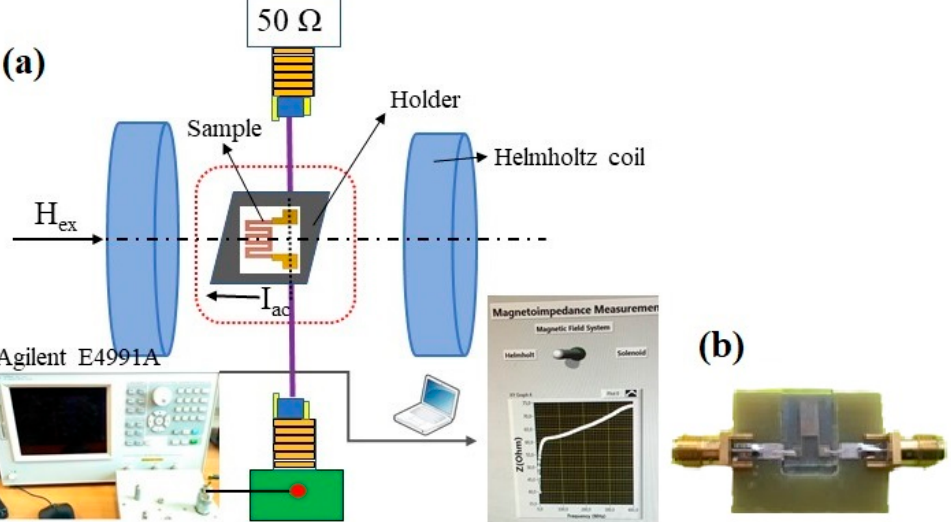
Figure 2. Schematic view of the MI measuring system for meander samples ( a ) and and “microstrype line” type sample holder with incorporated meander sample ( b